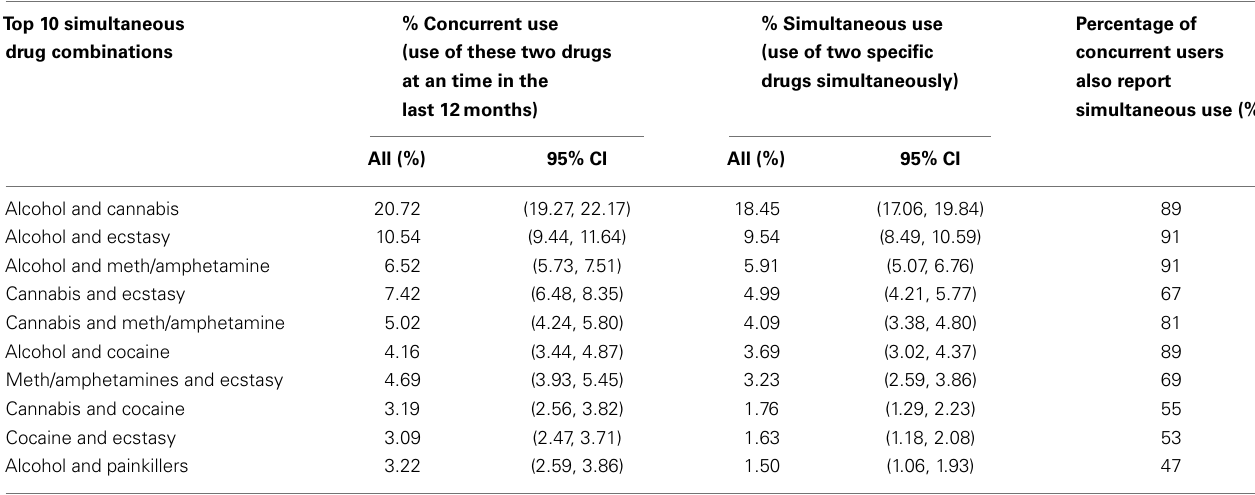
Table 3 | Percentage of participants reporting concurrent use, simultaneous use, and proportion of concurrent users who were also simultaneous users